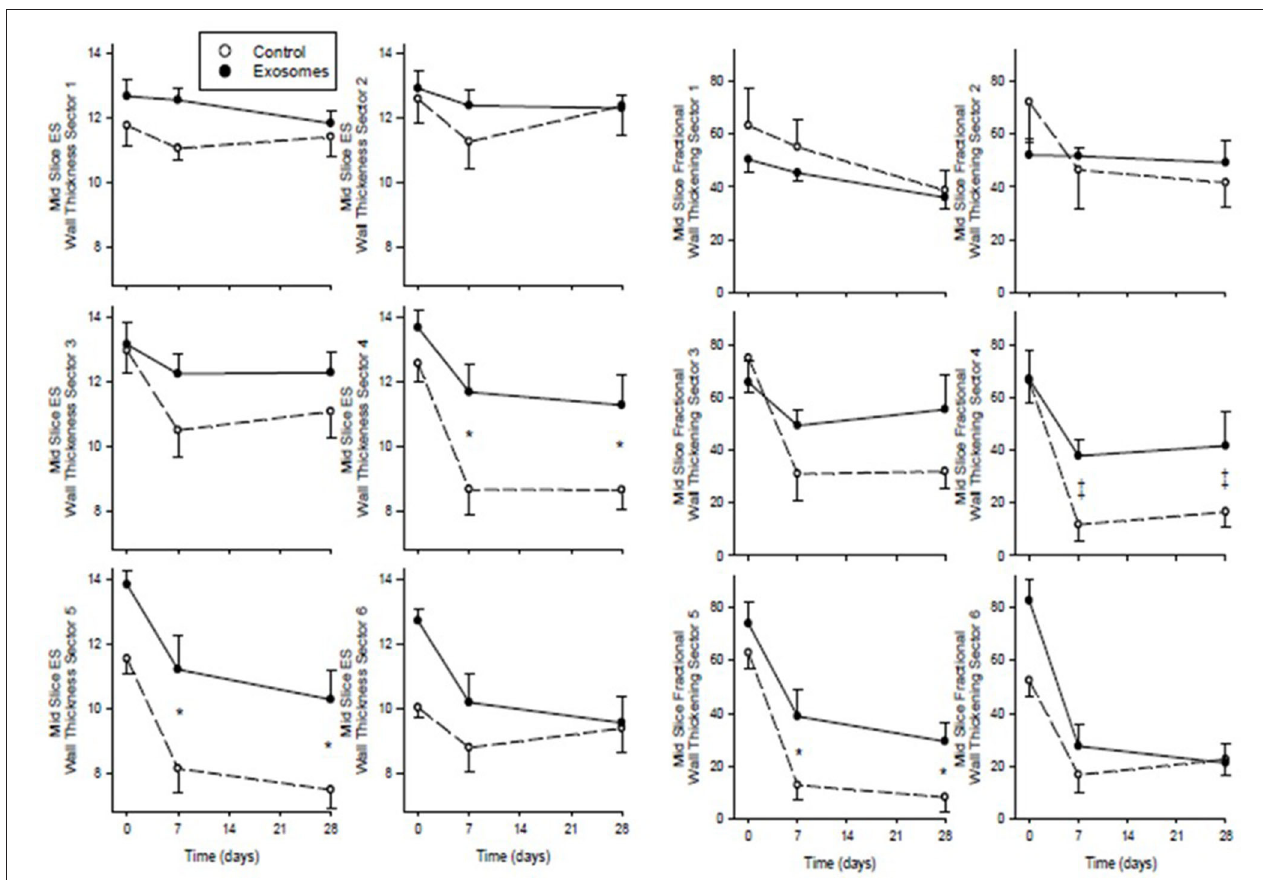
FIGURE 5 | Serial mid-slice end systolic (ES) wall thickness (left) and fractional wall thickening (right) measured by MRI across 6 sectors of the left ventricle spanning the infarct in ten pigs receiving 7 days intravenous administration of exosomes (•) following MI and ten pigs vehicle control ( ◦ ) treated pigs. Values shown are mean ± SEM. Significant differences at time-matched points between the exosomes and control pigs are indicated as follows: * p < 0.05 and ‡ p <